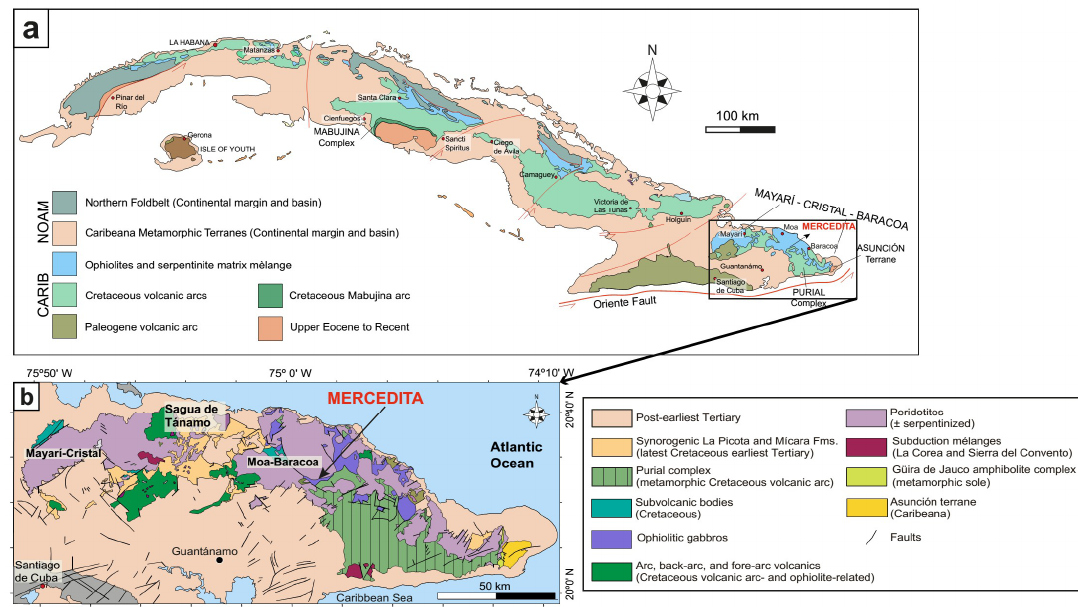
Figure 1. ( a ) Generalized geologic-tectonic map of Cuba; ( b ) Schematic geological map of the Mayarí‐Baracoa Ophiolitic Belt (MBOB) showing the location of the Mercedita Mine.